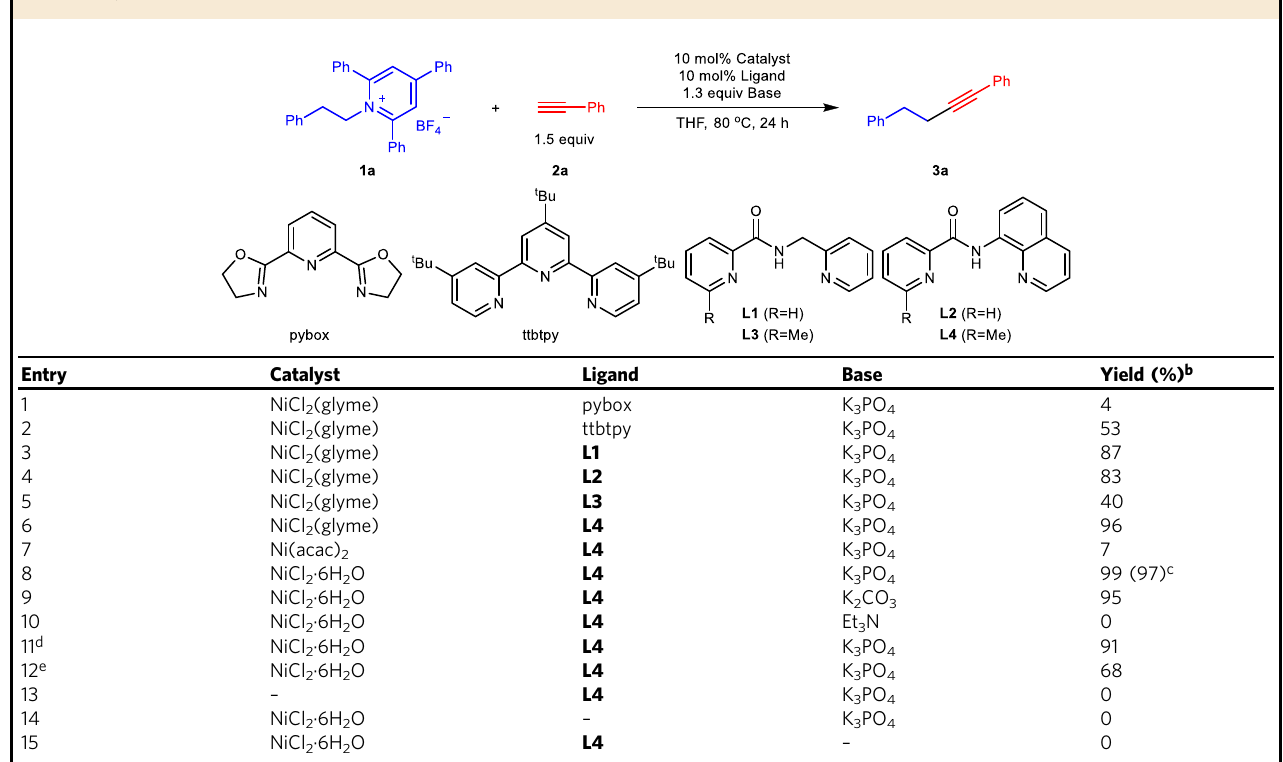
Table 1 Optimization of the reaction conditions a